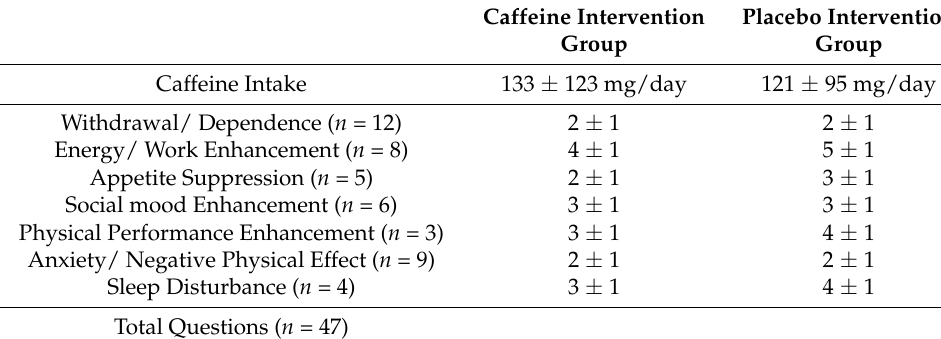
Table 1. Caffeine expectancy between caffeine and placebo